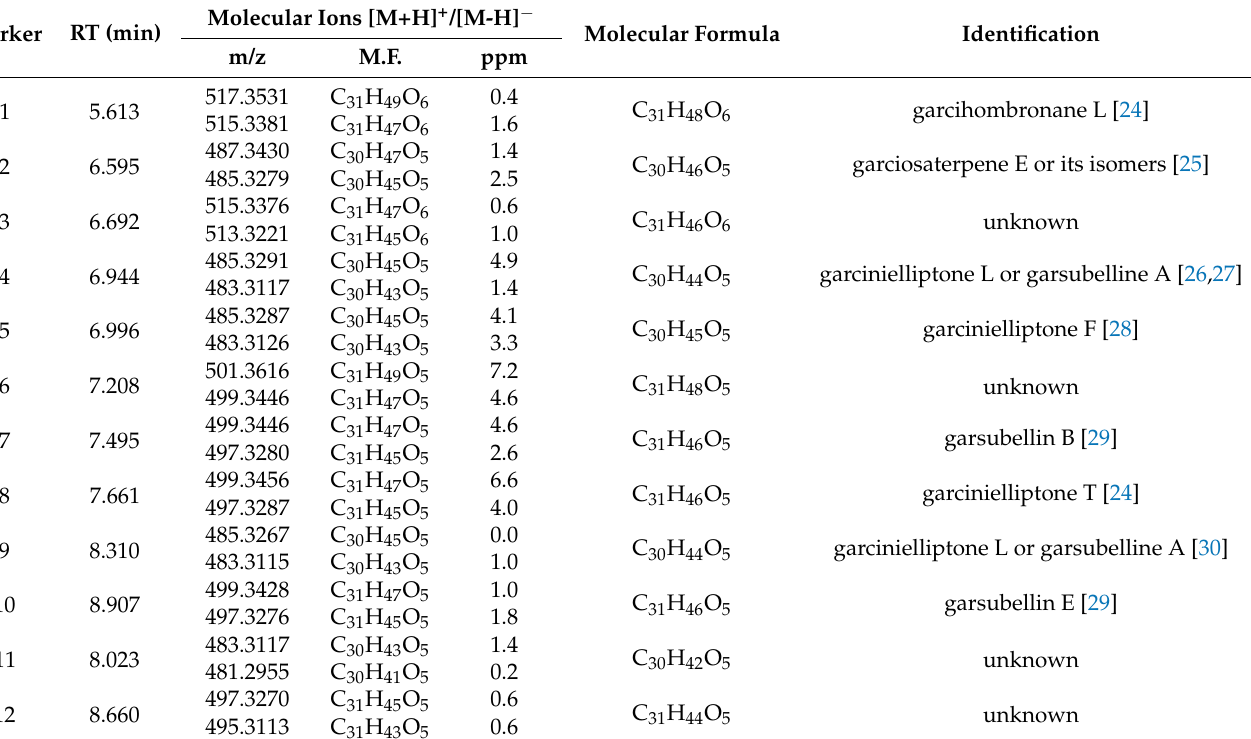
Table 2. Tentative identification of markers from bioactive fraction parts in seed extract.